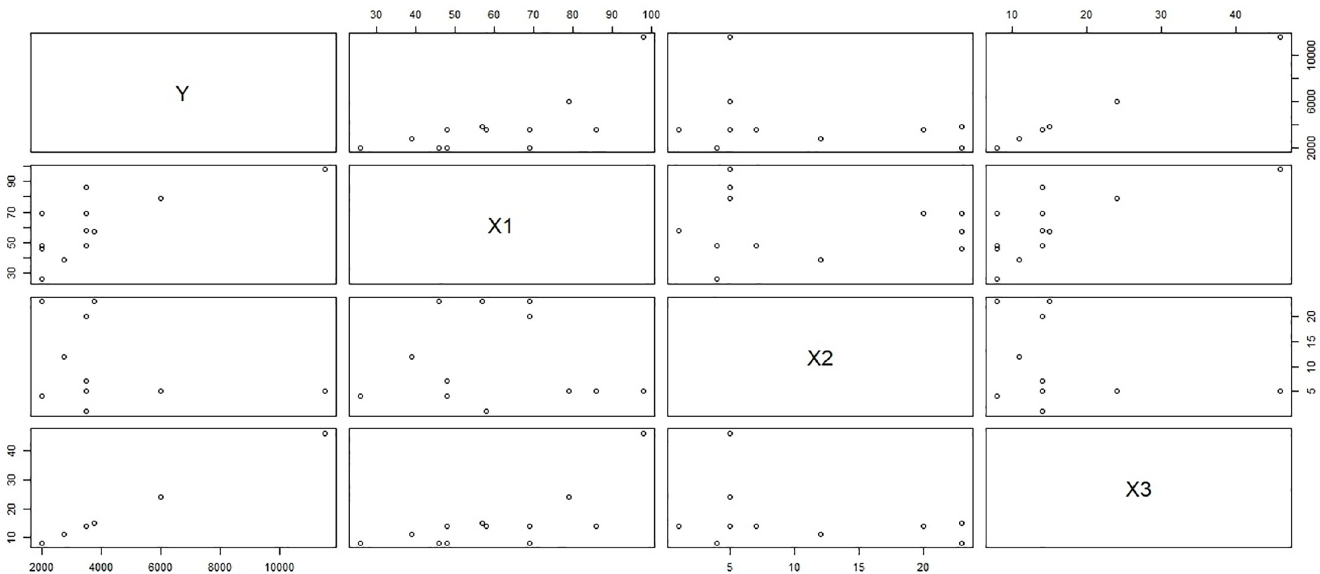
Fig 3. Behavior of non-respondents with λ 2 = 0.2.